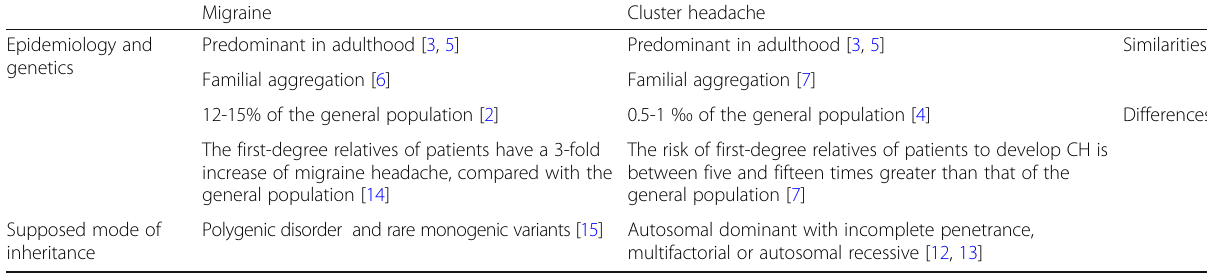
Table 1 Epidemiological and genetic similarities and differences in migraine and cluster